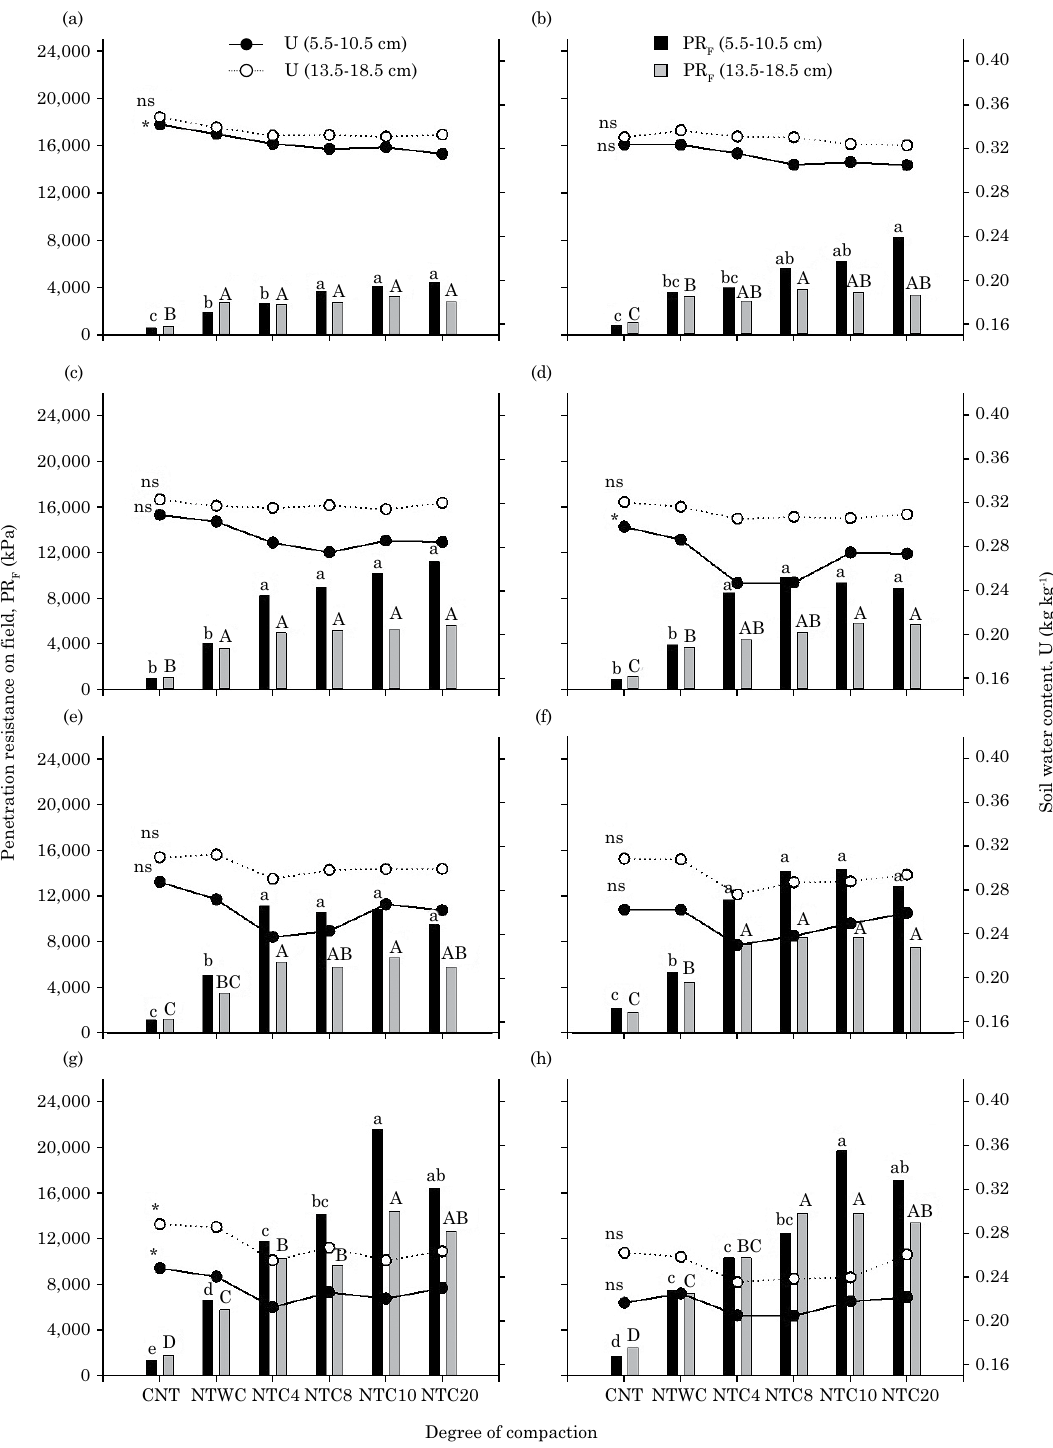
Figure 3. Values of soil mechanical resistance to penetration in the field (PR f ) and gravimetric content of the soil as related to degrees of compaction [no-tillage (NT) chiseled (CNT); NT without additional compaction (NTWC); NT with additional compaction of a combine passing 4 (NTC4), 8 (NTC8), 10 (NTC10), and 20 (NTC20) times] over a Rhodic Eutrudox, in the 5.5-10.5 and 13.5-18.5 cm layers (adapted from Moraes et al, 2013) for each evaluation period: 2 (a), 4 (b), 7 (c), 9 (d), 11 (e), 14 (f), 23 (g), and 31 (h) days after irrigation. Means followed by the same uppercase letter (5.5-10.5 cm layer) or lowercase letter (13.5-18.5 cm layer) do not differ by the Tukey test (p<0.05); ns: not significant by the F test